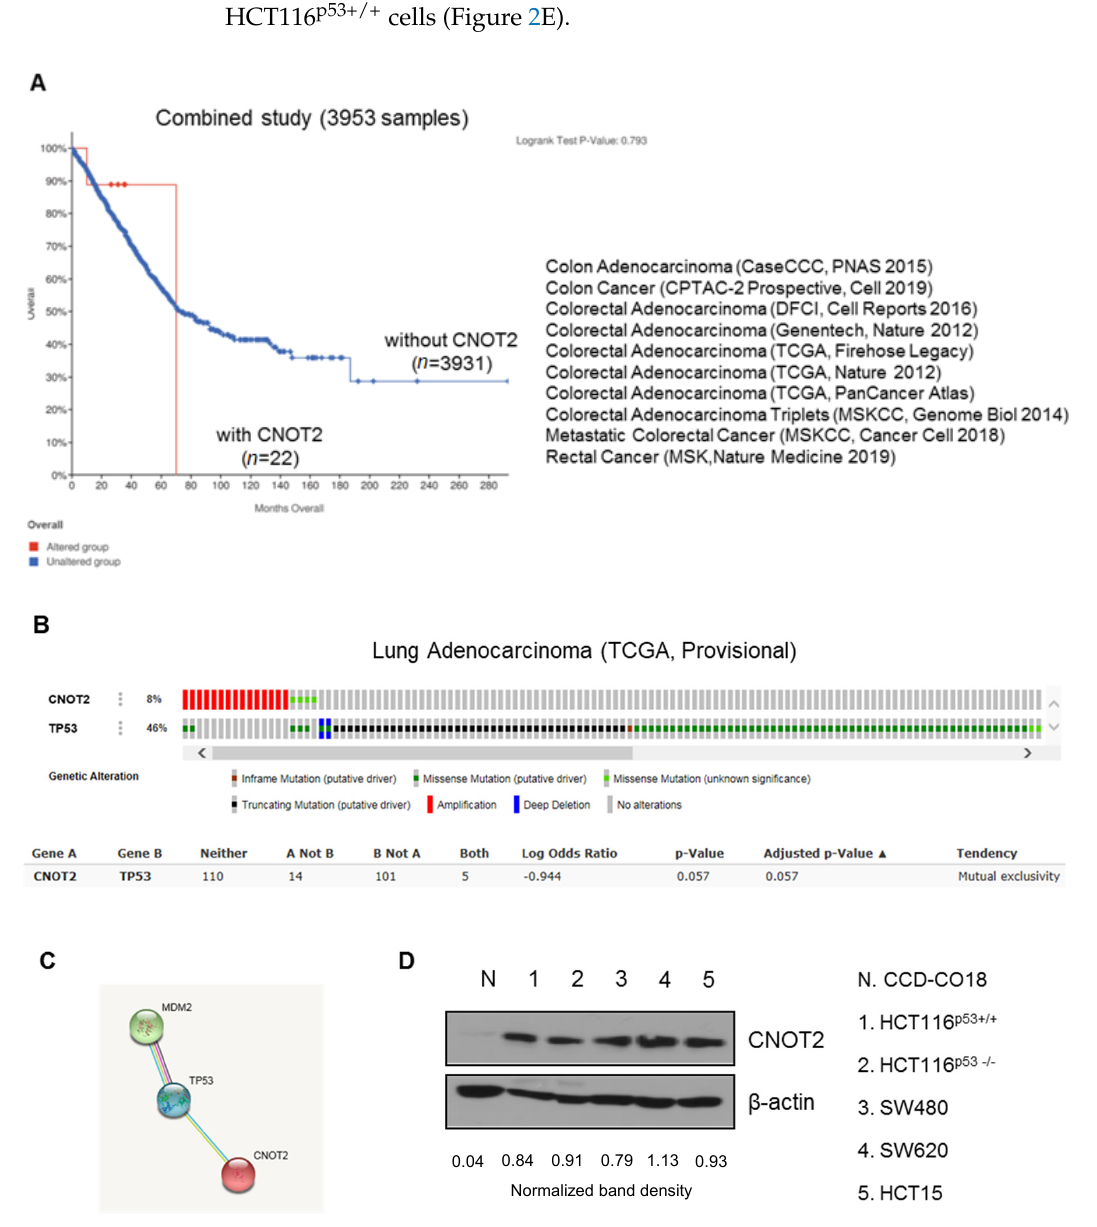
Figure 1. CNOT2 expression in cancer cells. ( A ) TCGA databases, modified from the cBioPortal for Cancer Genomics (http://www.cbioportal.org, accessed on 10 August 2020). ( B ) Analysis of mutual exclusivity was retrieved from cBioPortal and gene alteration status of CNOT2 and TP53 of individual samples. ( C ) Protein–protein interactions, wherein STRING v10 predicts binding between MDM2, p53, and CNOT2. ( D ) CNOT2 protein level in various colon cancer cells was assayed using Western blotting.